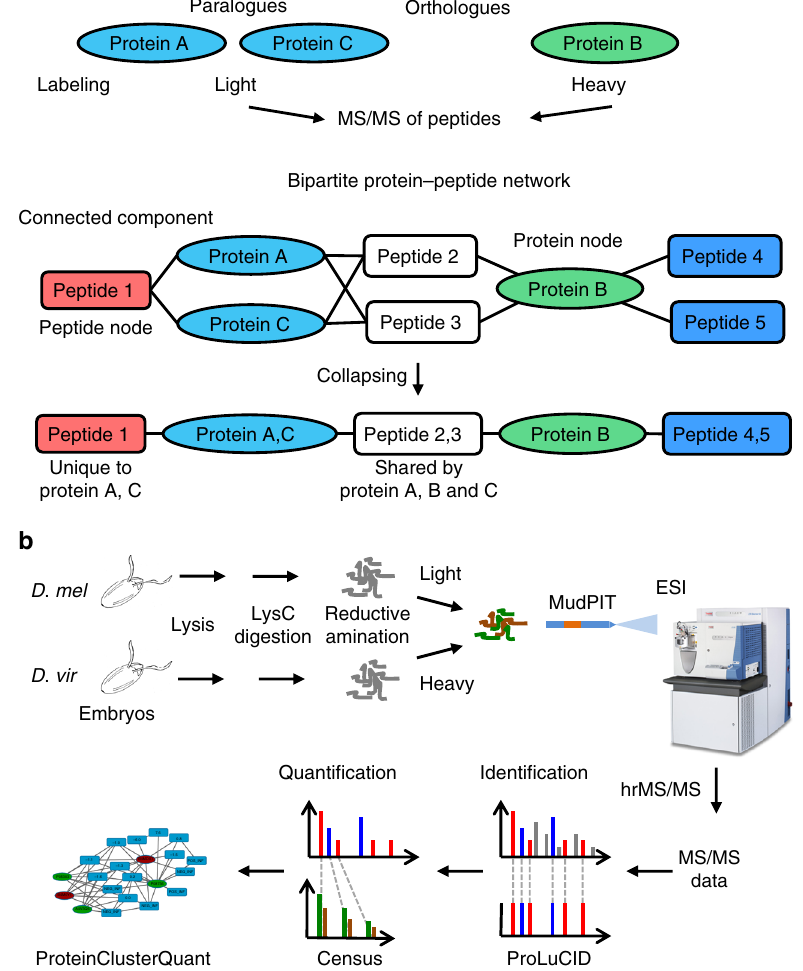
Fig. 1 Peptide-to-protein clusters in bottom-up proteomics. a The schematic shows two orthologous proteins A or B (ellipses) present in D . melanogaster (blue) or D . virilis (green) embryos, respectively. Protein C is a paralog of protein A that is a result of a gene duplication in D . melanogaster . Proteins A and C are detected with a D . melanogaster -speci fi c, unique peptide 1 (red rectangle) and protein B with peptides 4 and 5 (dark blue). Peptides 2 and 3 (white) are present in both orthologs A and B as well as in protein C. The peptide-to-protein cluster can be simpli fi ed in case proteins that share identical peptides are collapsed in one protein node and peptides that are shared by the same proteins are subsumed in one single peptide node. The D . melanogaster proteome is labeled light and D . virilis proteome is labeled heavy with isobaric isotopologues. b The schematic shows the work fl ow for a two-species comparison with isobaric isotopologue labeling. Drosophila embryos were lysed and digested with the endoprotease LysC, primary amines were dimethylated with isobaric isotopologues as light or heavy and the sample was analyzed with MudPIT on an Orbitrap series mass spectrometer. Peptides were identi fi ed with ProLuCID in a database search and isobaric isotopologues subsequently quanti fi ed with Census and peptide-to-protein networks analyzed in ProteinClusterQuant. Abbreviations: vir : virilis , mel : melanogaster , ESI: electrospray ionization, MS: mass